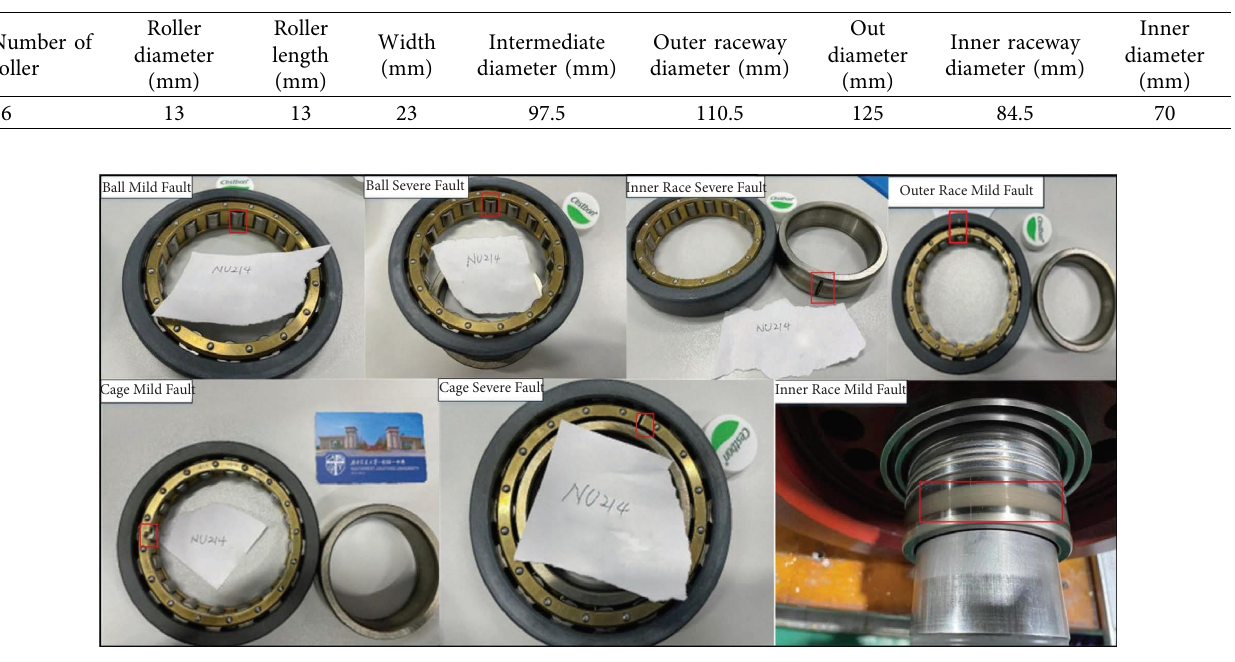
Figure 2: Faulty bearings.